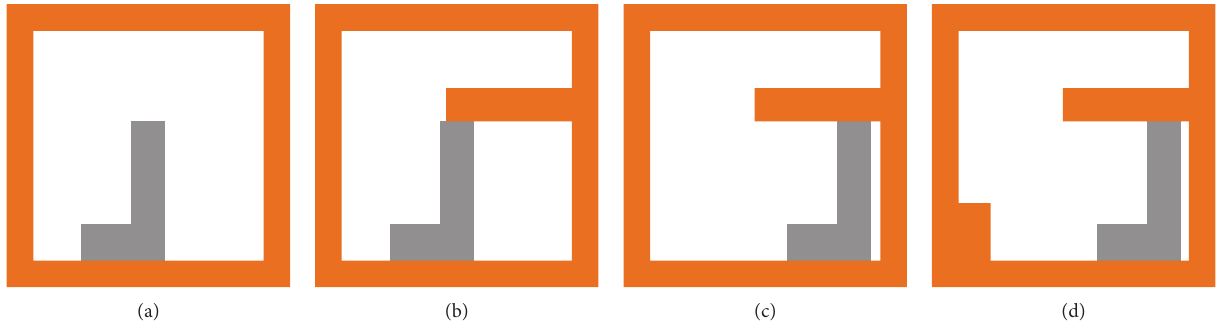
Figure 2: Evaluation steps of the proposed antenna. (a) Antenna 1, (b) Antenna 2, (c) Antenna 3, and (d) Antenna